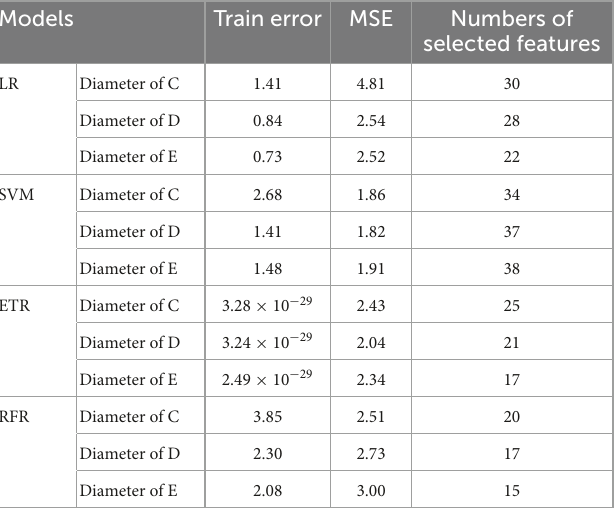
TABLE 2 Performance of models in test and train sets.